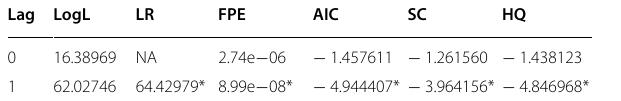
Objects in parenthesis are the various t -statistics